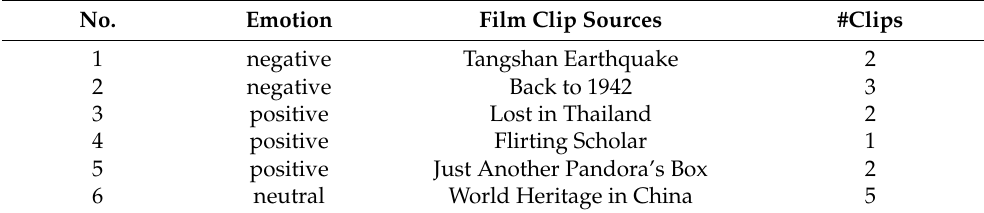
Table 1. The selected film clips used to elicit target emotions in the SEED dataset.